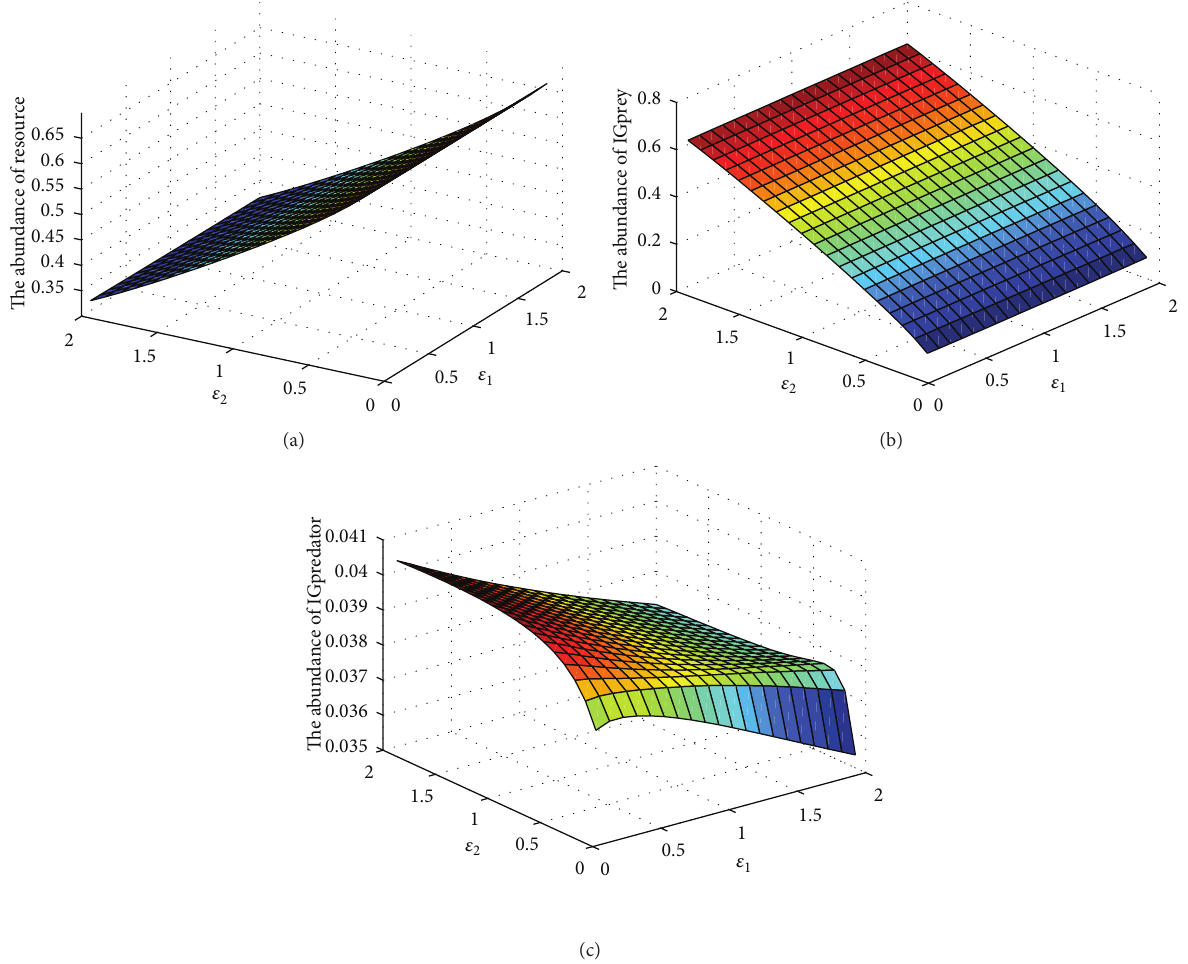
Figure 4: Long-term (equilibrium) abundances of the resource, the IGprey and the IGpredator as a function of the IGprey’s dispersal rate ( 𝜀 1 ) and the IGpredator’s dispersal rate ( 𝜀 2 ). Parameter values used are: 𝜅 1 = 0.7, 𝜅 2 = 0.2, 𝜅 3 = 0.23 , 𝛼 = 2, ℎ = 0.5, 𝑒 1 = 0.1 , and 𝑒 2 = 0.21